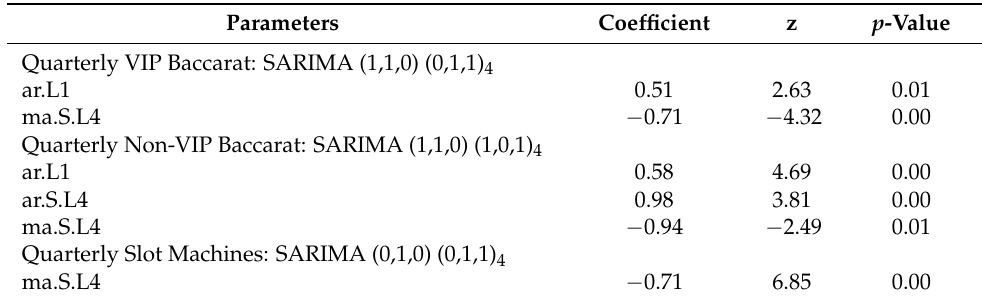
Table 1. Summary of estimates of model parameters.